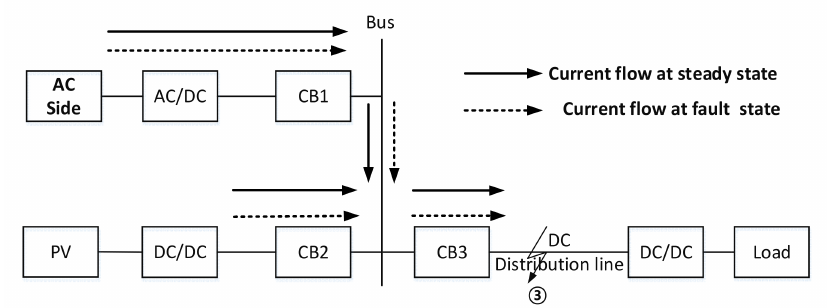
Figure 4. Comparison of the current flow in the steady state and in a fault in section 3 (cid:13) .